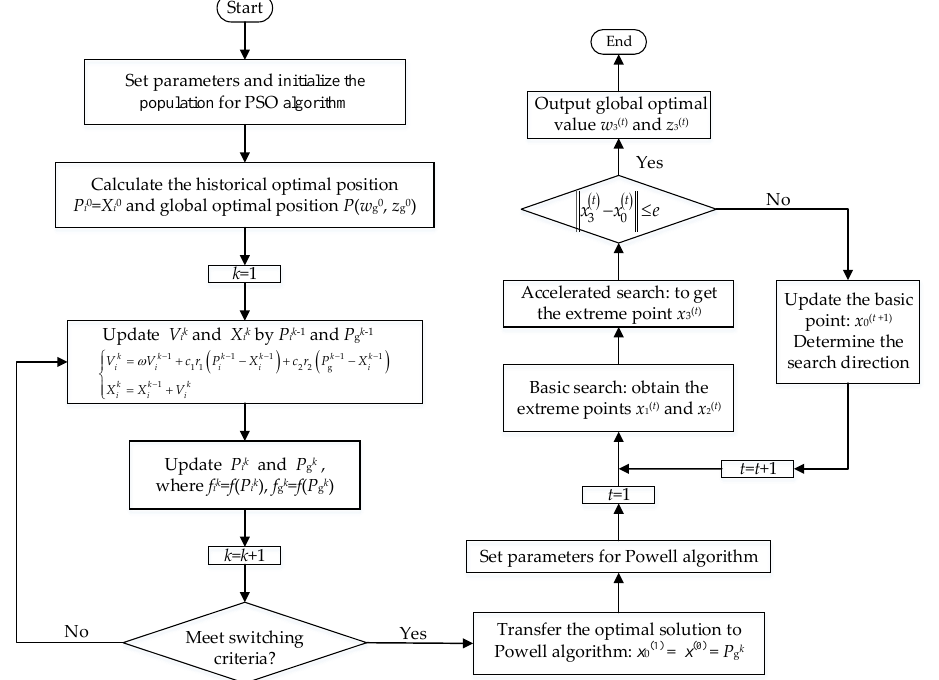
Figure 8. Flowchart of parameter extraction based on a hybrid algorithm of particle swarm optimization (PSO) – Powell.